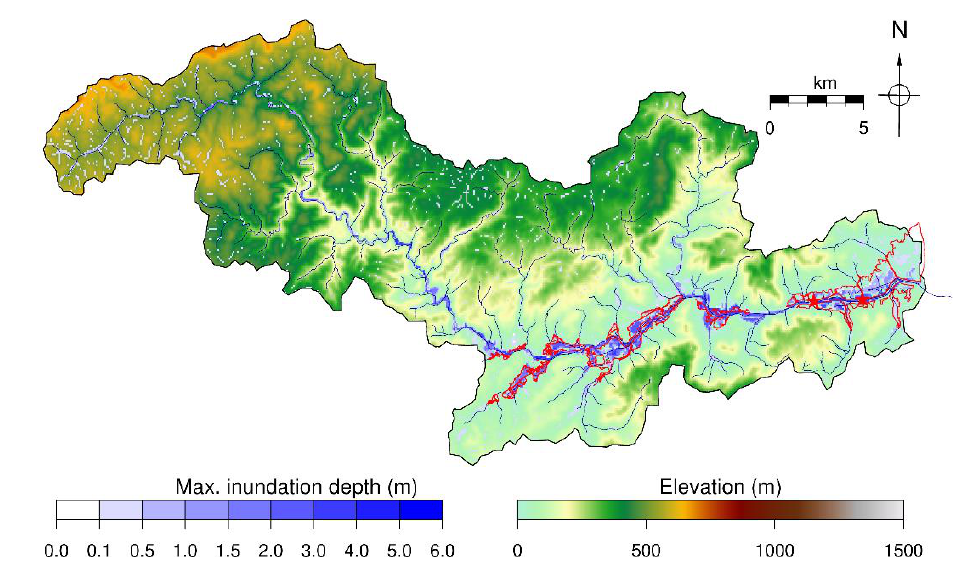
Figure 8. The maximum inundation flood depth profile over the Oda river basin. Red polygons are the estimated flood inundated area based on the GSI maps.